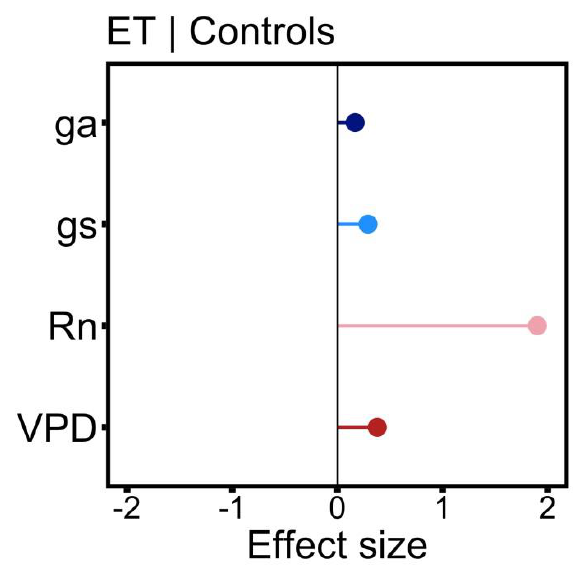
Figure 9. Drivers of evapotranspiration (ET) in the seasonally dry Atlantic Forest (SDAF) indicated